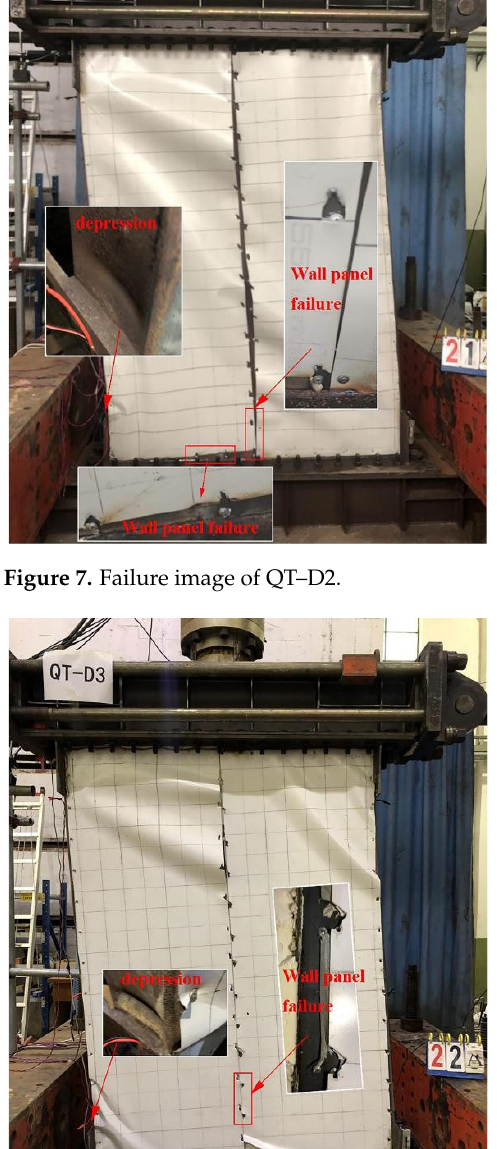
Figure 6. Failure image of QT − D1.